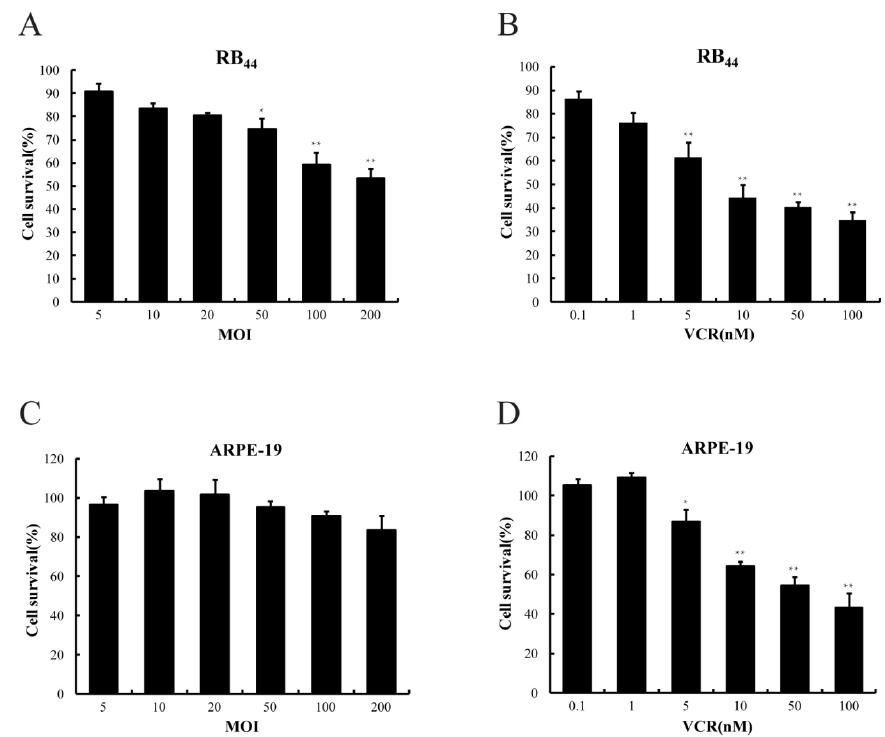
Figure 1. Growth inhibition following treatment with adenovirus (SG600) or vincristine (VCR) on HXO-RB ( A , B ) cells and normal cells ( C , D ). Bars: standard deviation. The 44 results are representative of three independent experiments and of four replicates in each experiment. ** p < 0.01 relative to the SG600 or VCR treatment group.